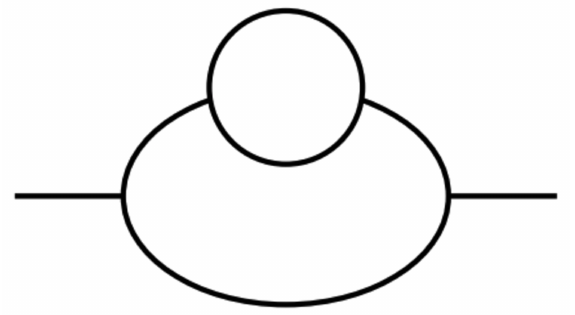
Figure 3 . Sub-subleading order:A.